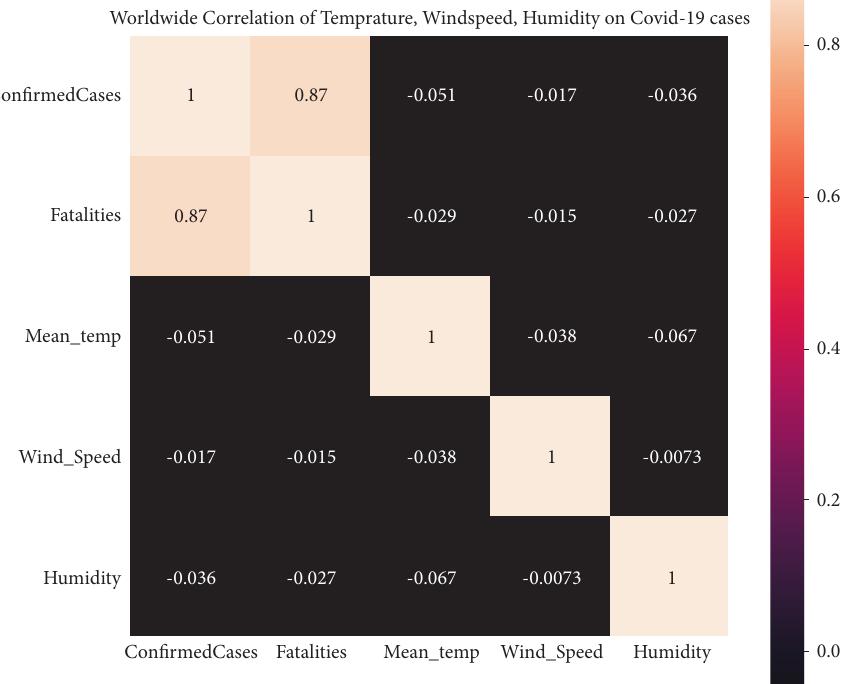
Figure 3: Worldwide correlation of temperature, windspeed, and humidity on COVID-19 cases.